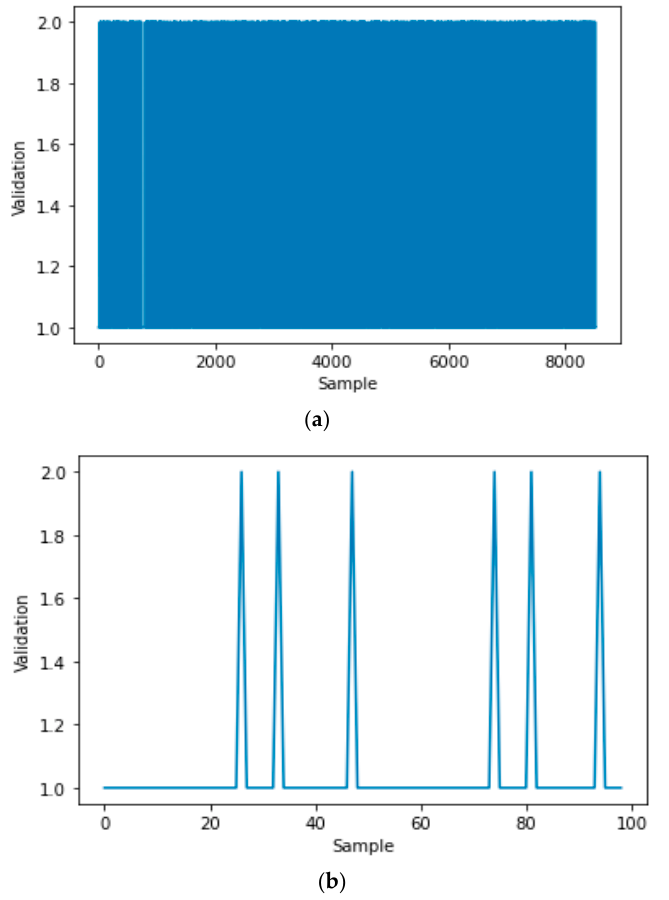
Figure 4. The output training dataset of the decision tree: ( a ) all output of training dataset, ( b ) zoomed in on a few samples from the output training dataset.